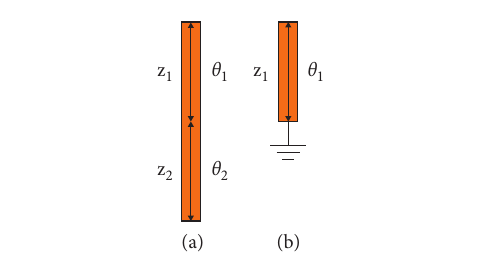
Figure 3: (a) Even-mode resonator. (b) Odd-mode